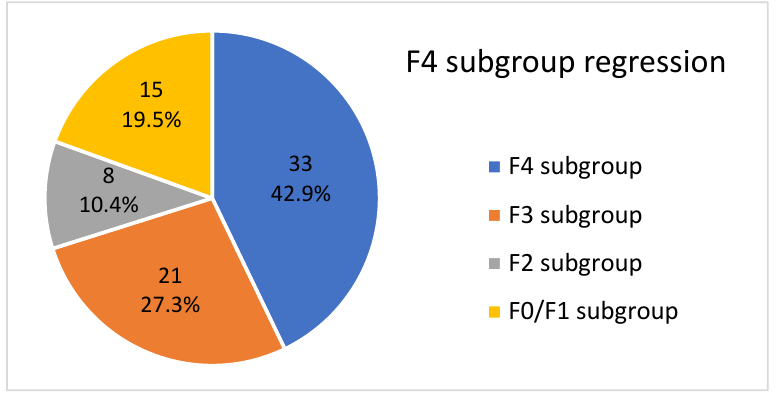
Figure 10. Graphic description of the fibrotic stage in F4 patients at the end of the follow-up period.